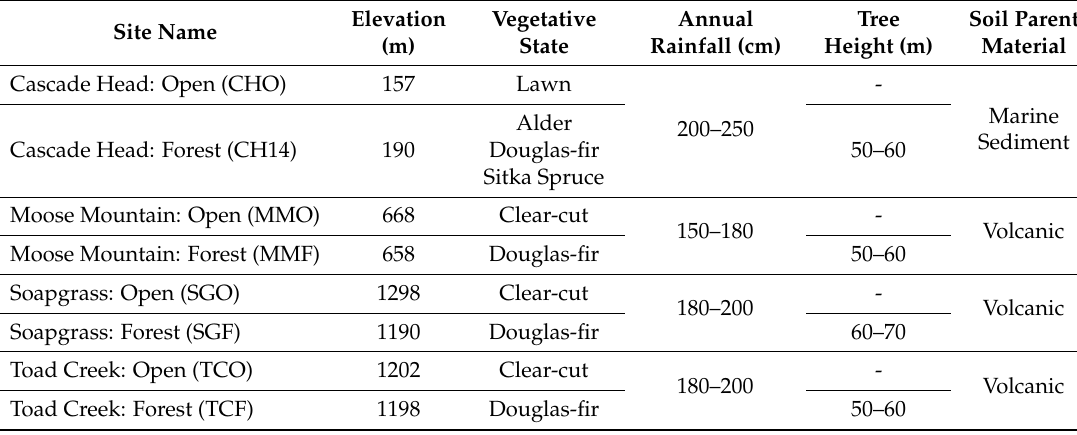
Table 2. O’CCMoN Open and Forest Site